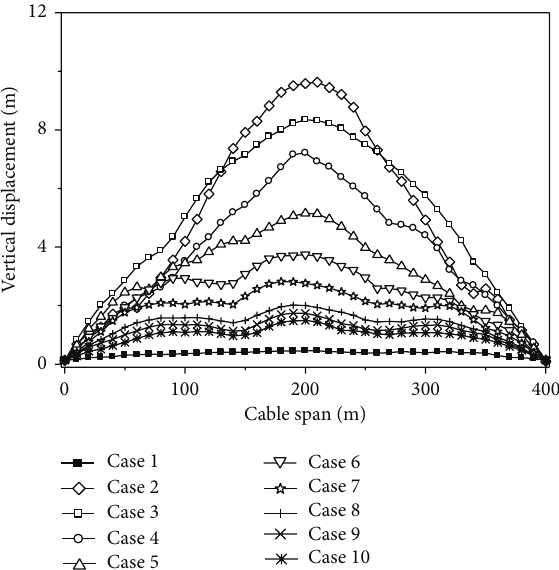
Figure 6: Vertical displacements of the cable under different traveling wave velocities.